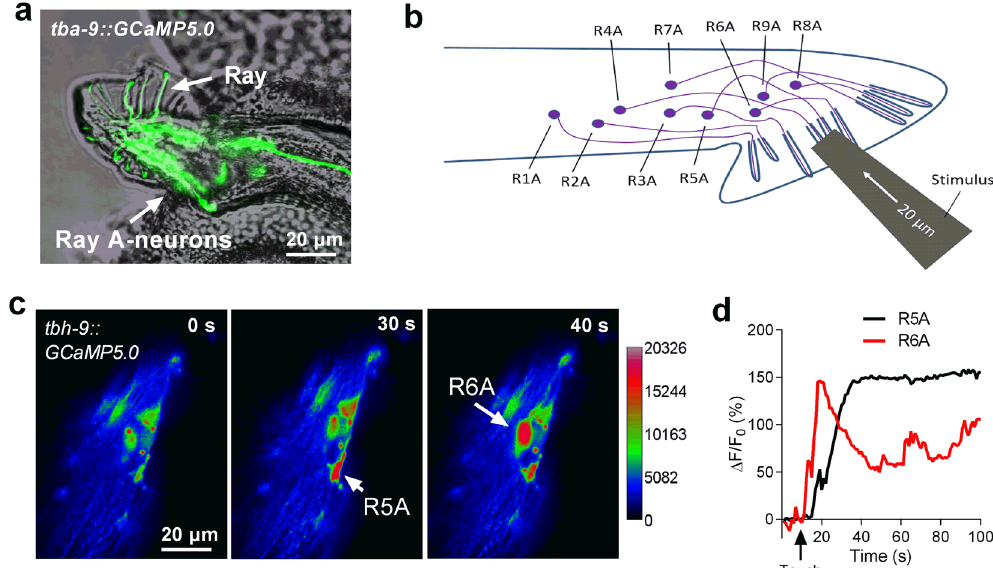
Figure 2. Touch-induced calcium responses in RnA neurons. ( a ) Micrograph of the male tail showing the expression of tba-9::GCaMP5 . 0 in the rays. ( b ) A schematic illustrating of delivering mechanical stimulation toward the RnA cilia (at the position of rays 4–6 is shown). ( c , d ) Representative time-lapse rainbow images of GCaMP5.0 based calcium responses ( c ) and soma fluorescence changes ( d ) from R5A and R6A neurons induced by mechanical stimulation of 20 μ m displacement at the position of ray5 and ray6.